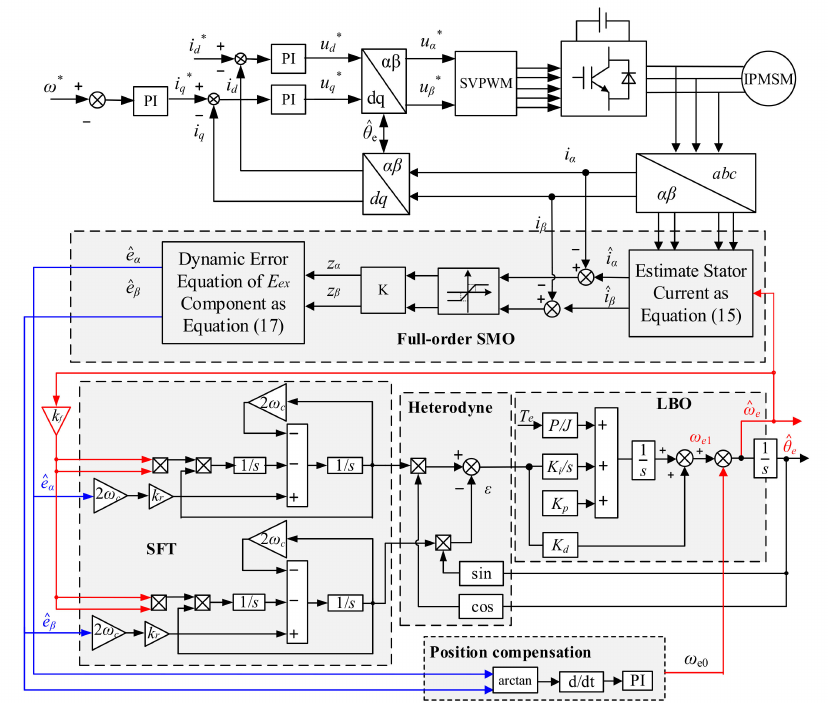
Figure 9. Overall structure of the SFT and LBO-based IPMSM sensorless speed